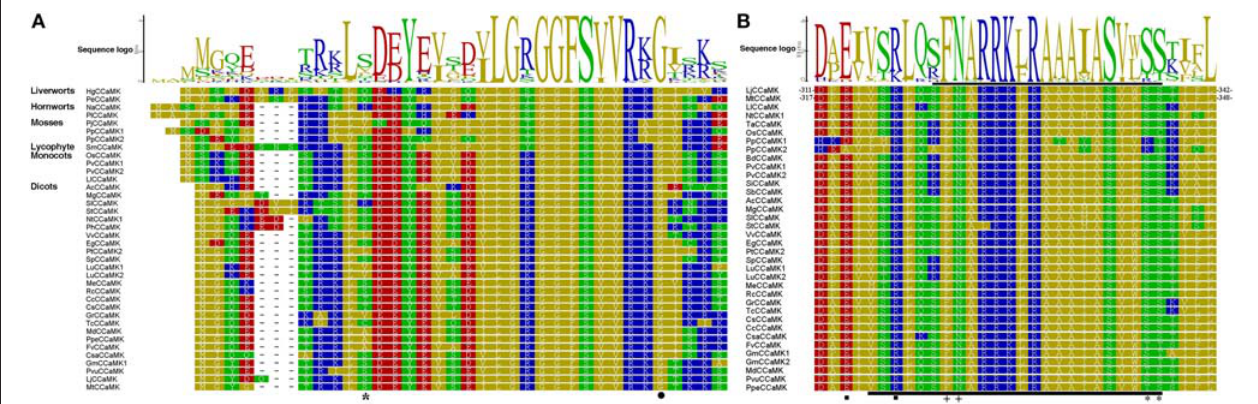
FIGURE 3 | Protein sequence logos for the kinase domain N-terminal and autoinhibitory/CaM-binding domain of CCaMK proteins. (A) Shows the logo for N-terminal of the kinase domain of sequences from various plant species. (B) Indicates the autoinhibitory domain overlapping with the CaM-binding domain. These two domains are shown by the black bar below and above the alignment, respectively. The two of autoinhibition stabilizing residues are shown by the solid black boxes, CaM-binding site is indicated by “plus” sign, CCaMK autophosphorylation sites are indicated by “asterisk,” while the position of G30 in LjCCaMK is indicated by the solid black